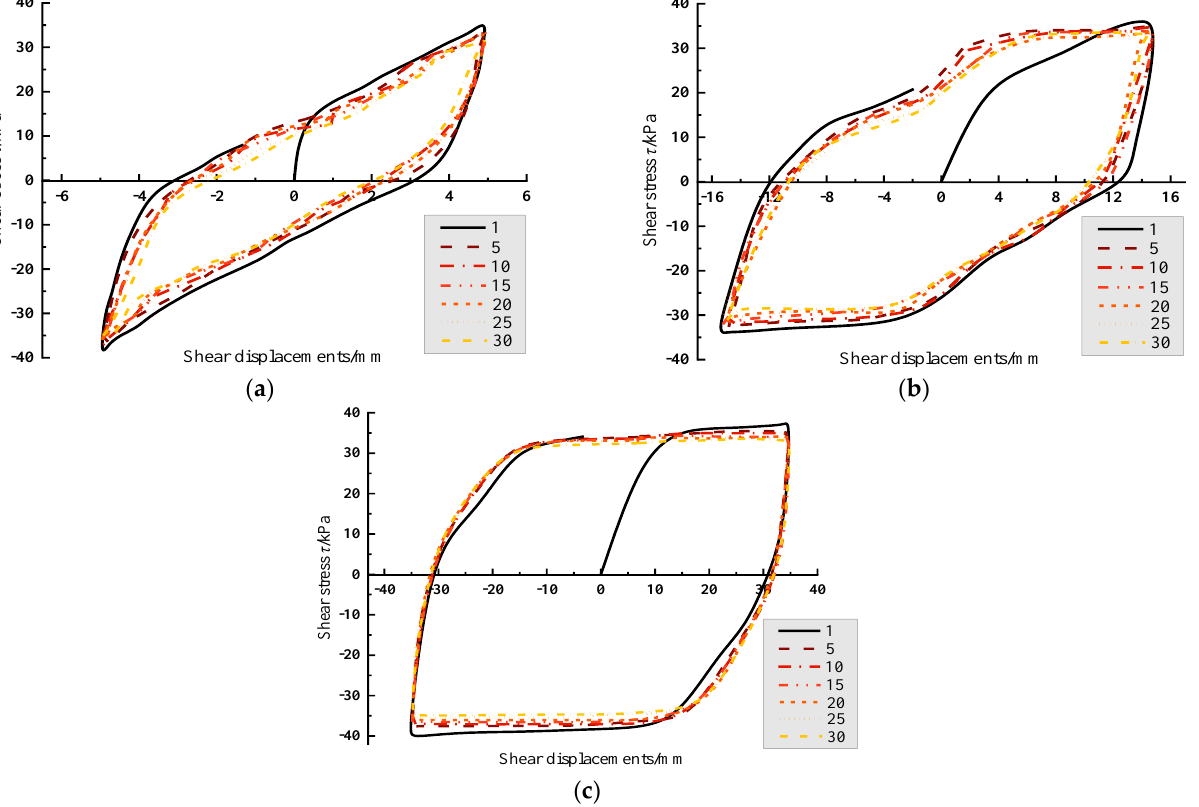
Figure 6. Shear stress-shear displacement curves with different shear amplitudes: ( a ) 5 mm; ( b ) 15 mm; ( c ) 35 mm.